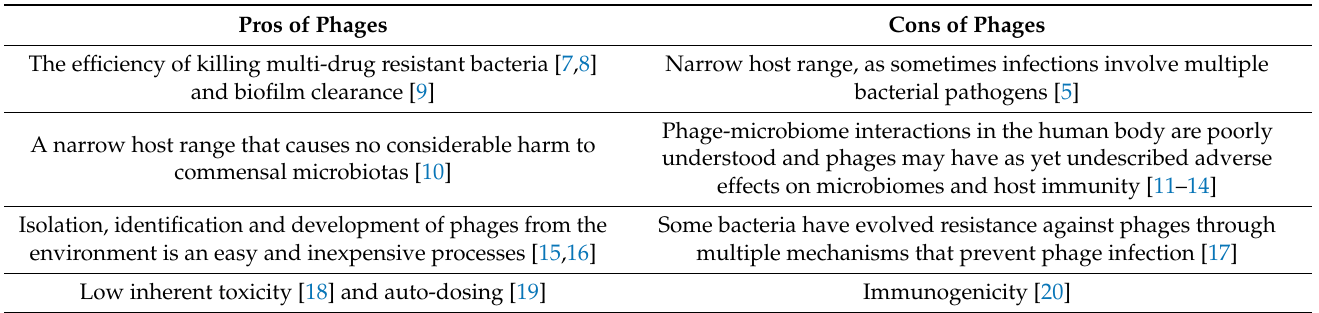
Table 1. Shows a brief comparison between advantages and disadvantage of phages over antibacterial agents. Pros of Phages Cons of Phages The efficiency of killing multi-drug resistant bacteria [7,8] Narrow host range, as sometimes infections involve multiple and biofilm clearance [9] bacterial pathogens